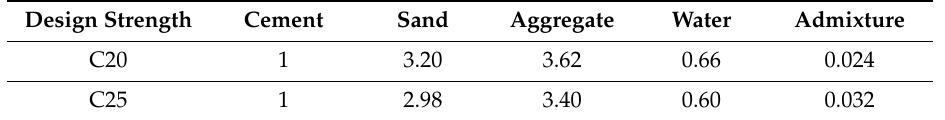
Table 2. Comparison of concrete compressive strength tests. Table 1. 3D printed ready-mixed concrete mix ratio.